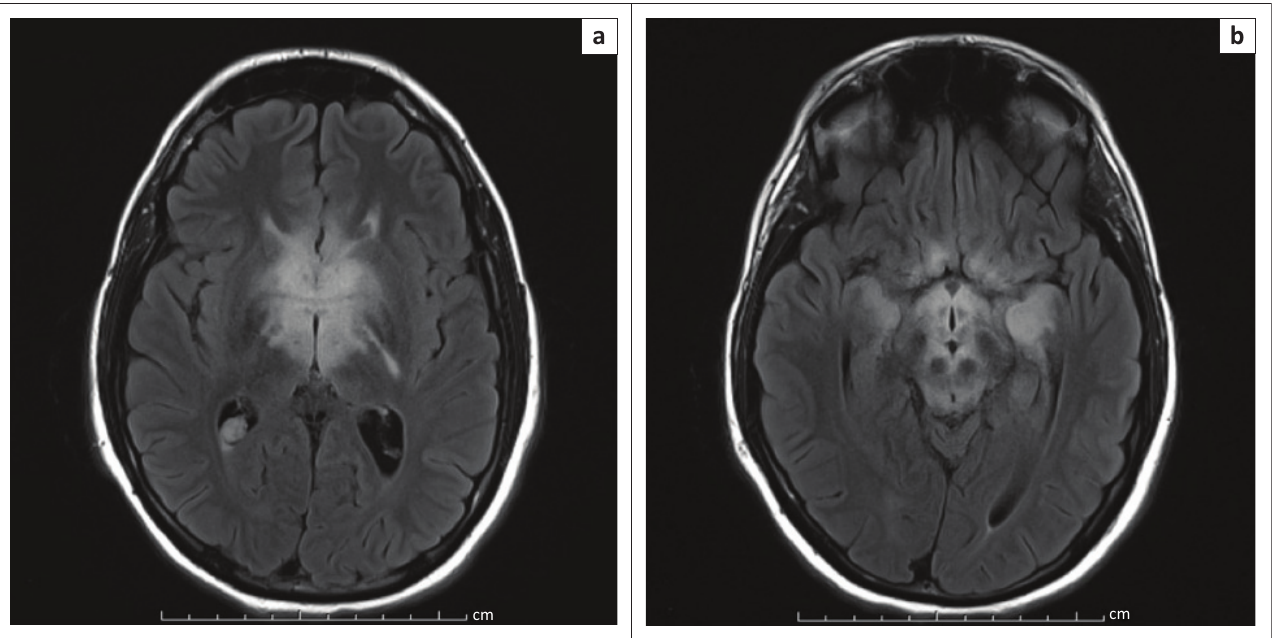
FIGURE 1: (a) Axial Fluid Attenuation Inversion Recovery (FLAIR) imaging demonstrating symmetric increased signal involving the basal ganglia and thalami bilaterally, (b) Increased signal intensity is also noted in the hypothalamus, anterior midbrain and to varying degrees in both medial temporal lobes.